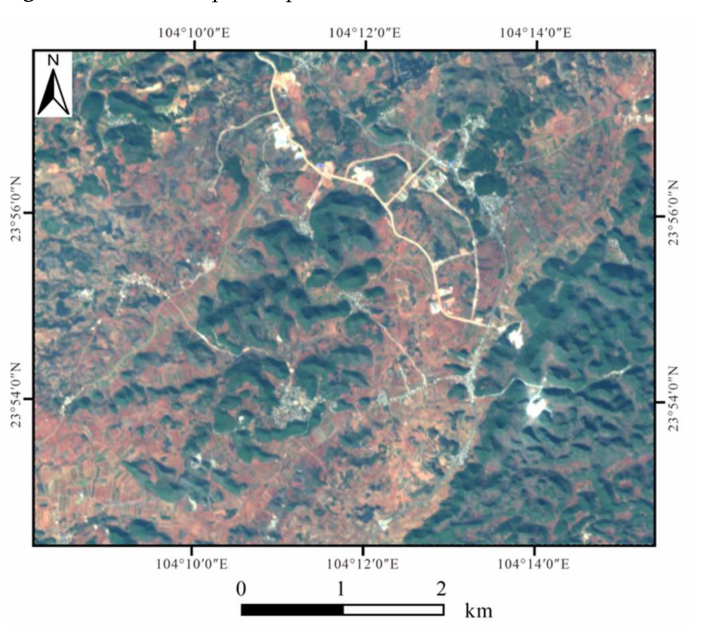
Figure 4. Raw GF-5 spectral profile.